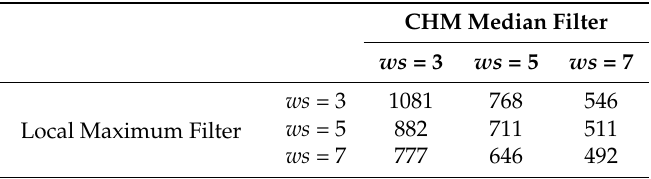
Table 6. Sensitivity analysis of filters used for tree detection for one LiDAR tile (index row: 82, column: 72). Shown are the counts of tall trees (>30 m) detected using different combination of filter sizes for the CHM Median Filter (smoothing filter) and the Local Maximum Filter (peak detection in CHM). The unit of the window sizes ( ws ) is meter.